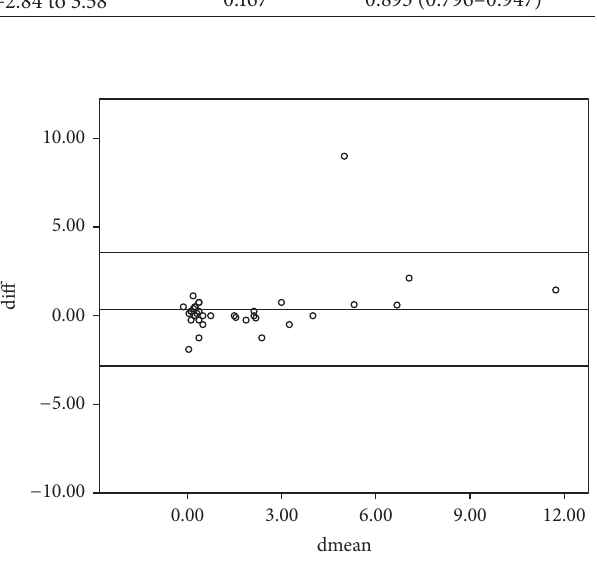
Figure 1: Bland-Altman plots comparing refractive measurements between autorefraction and retinoscopy (spherical equivalent). Dif- ference between the measurements (diff) is plotted on the vertical axis, and their mean is plotted on the horizontal axis (dmean). The middle horizontal line represents the mean difference and the two horizontal lines, one above and the other below, are the 95% limits of agreement between